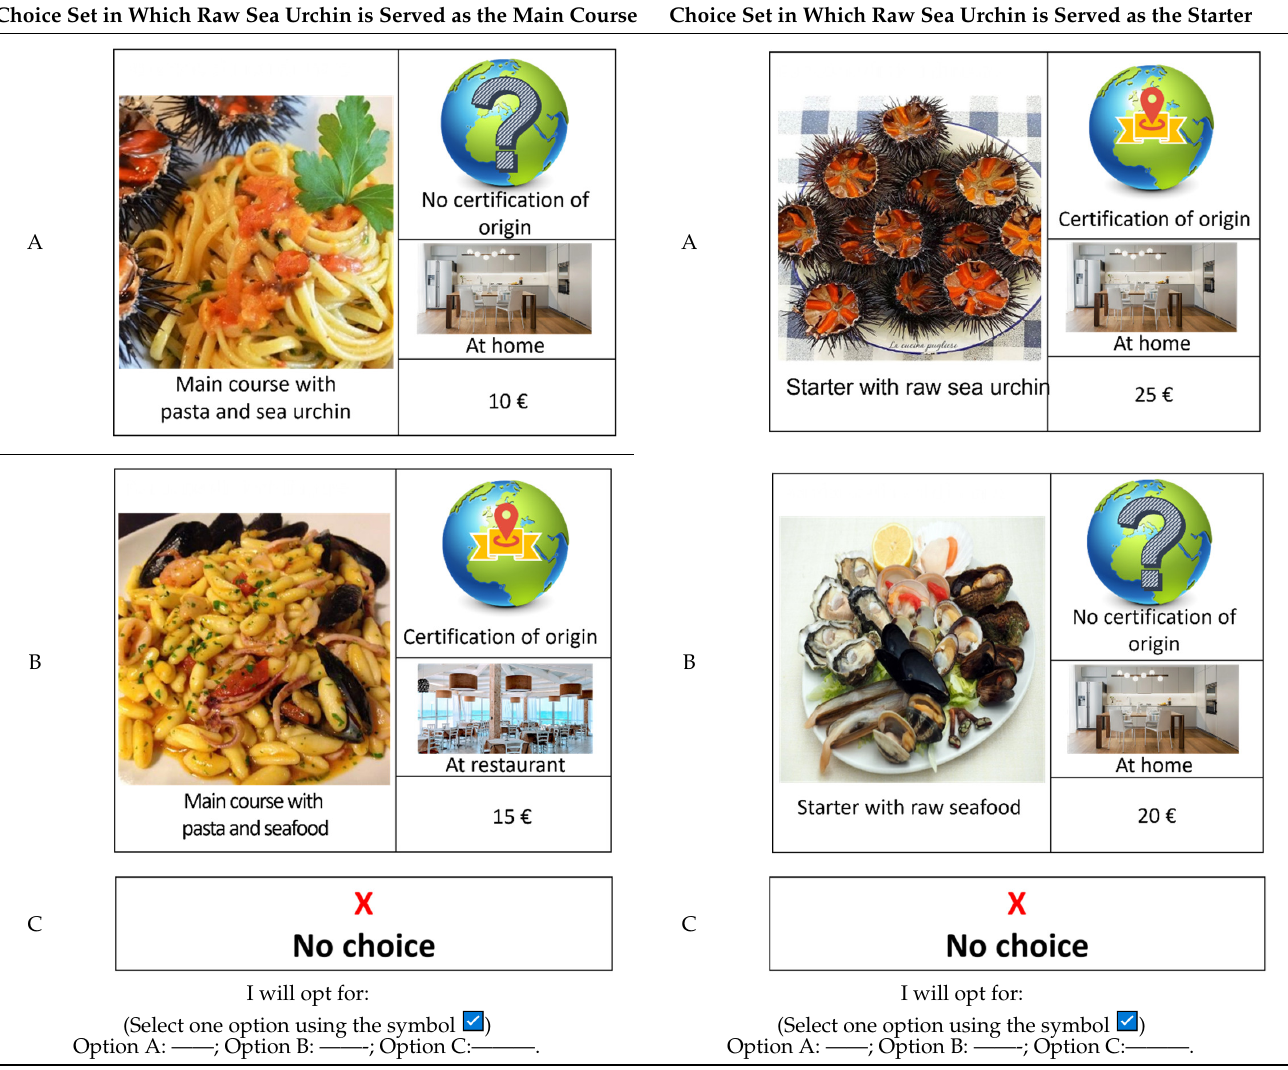
Table 2. Example of a set choice used in the survey.